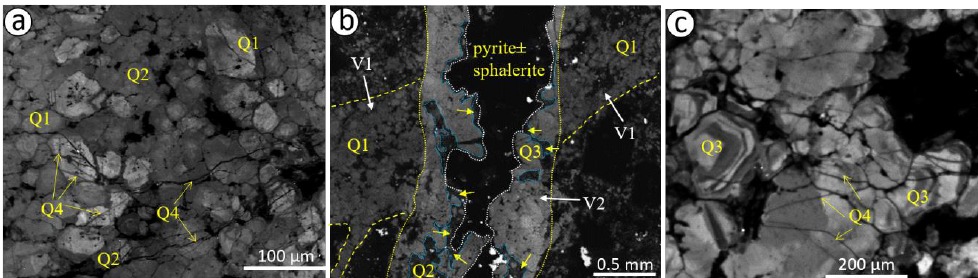
Figure 10. Multiple generations of quartz formation identified by SEM-CL imaging in ( a ) INT#1, ( b ) INT#2, and ( c ) INT#3. (Q1) CL-bright, light grey early generation, (Q2 and yellow arrows) CL-dark grey, dissolution quartz, (Q3) CL-dark grey and light grey bands, concentric zoning quartz, and (Q4) CL-grey to dark grey, micro-fracture filling, late-stage quartz.